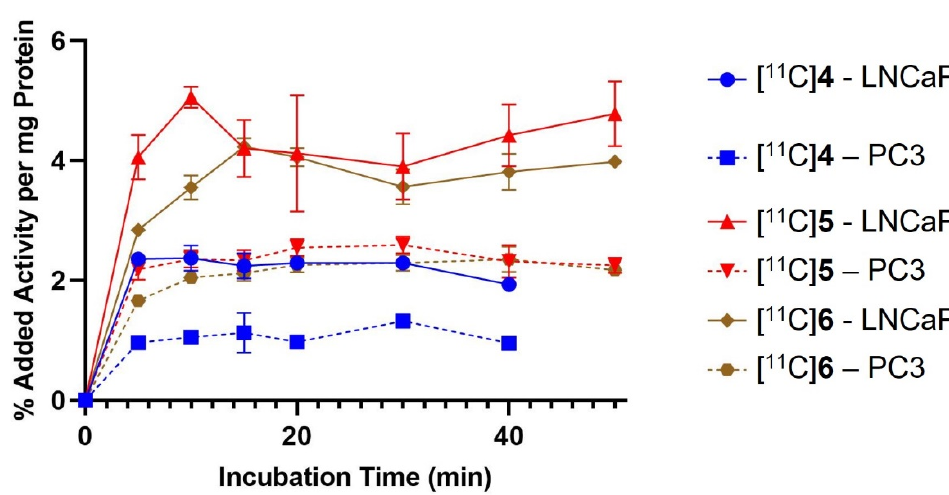
Figure 5. Time course binding of [ 11 C] 4 (blue), [ 11 C] 5 (red), and [ 11 C] 6 (brown) to LNCaP cells or PC3 cells incubated at 37 °C for up to 50 min. The counts were corrected for decay and normalized to protein content.